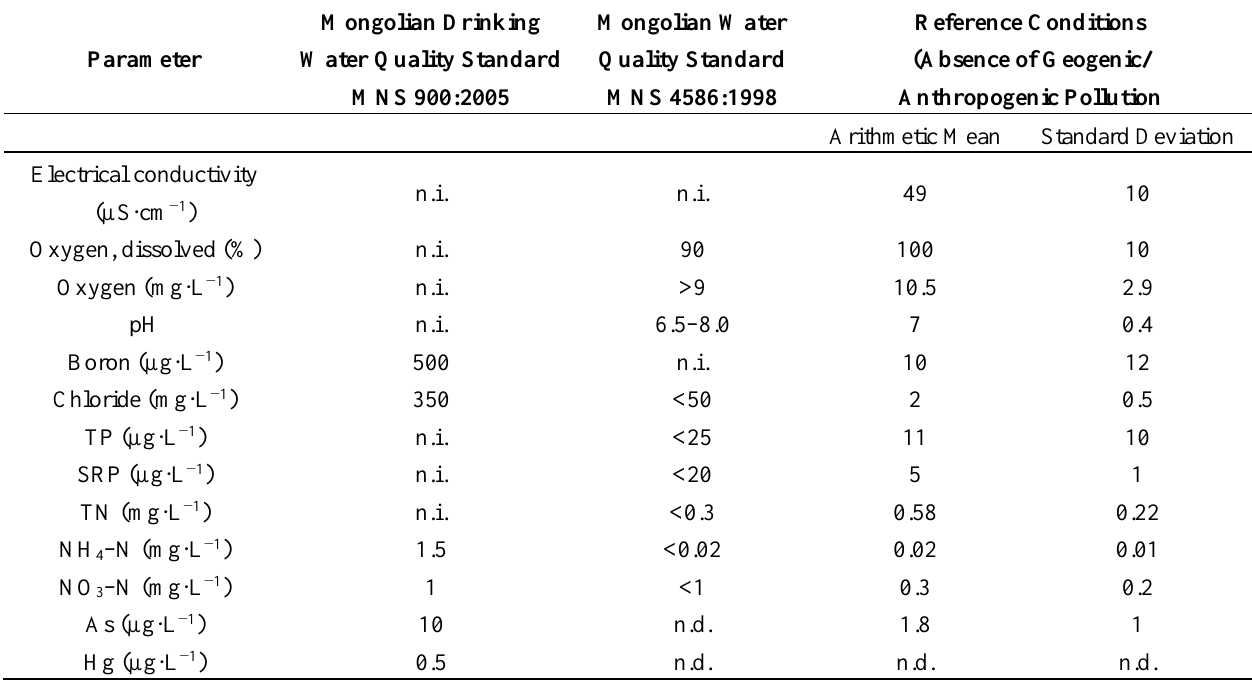
Table 7. Physico-chemical reference natural background conditions for the waterbody Kh_Trib_2 (Khentii reference) in comparison to the maximum tolerable concentrations of the Mongolian National Standards (MNS 900:2005, MNS 4586:1998)